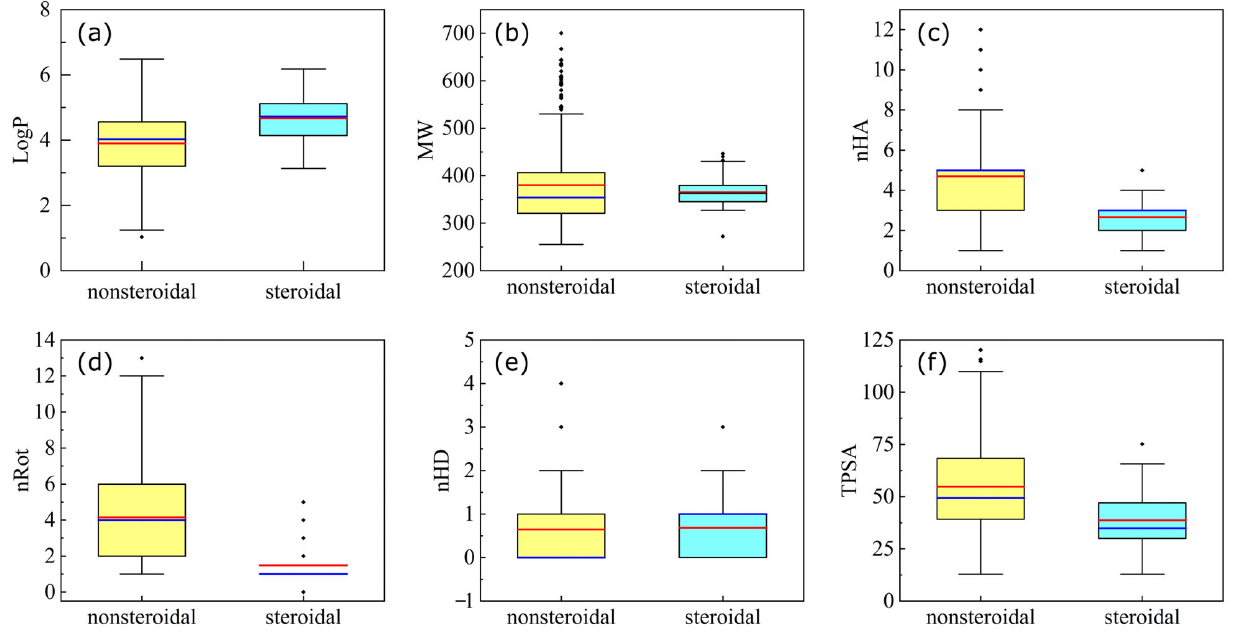
Figure 1. Box plot of drug likeness descriptors amongst nonsteroidal and steroidal inhibitors. Only potent/active molecules in nonsteroidal and steroidal categories were selected for the comparison. The average and the median are indicated by the red and blue lines, while the lower and upper quartiles are labeled by the lower and upper boundaries of the box, respectively. Panel ( a ), ( b ), ( c ), ( d ), ( e ), and ( f ) show the distributions of LogP, MW, nHA, nRot, nHD, and TPSA, respectively.